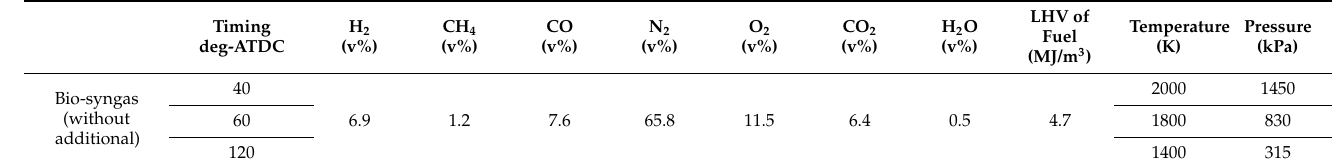
Table 5. Calculation conditions for investigation of freezing at expansion stroke. The temperature and the pressure are changed depending on the